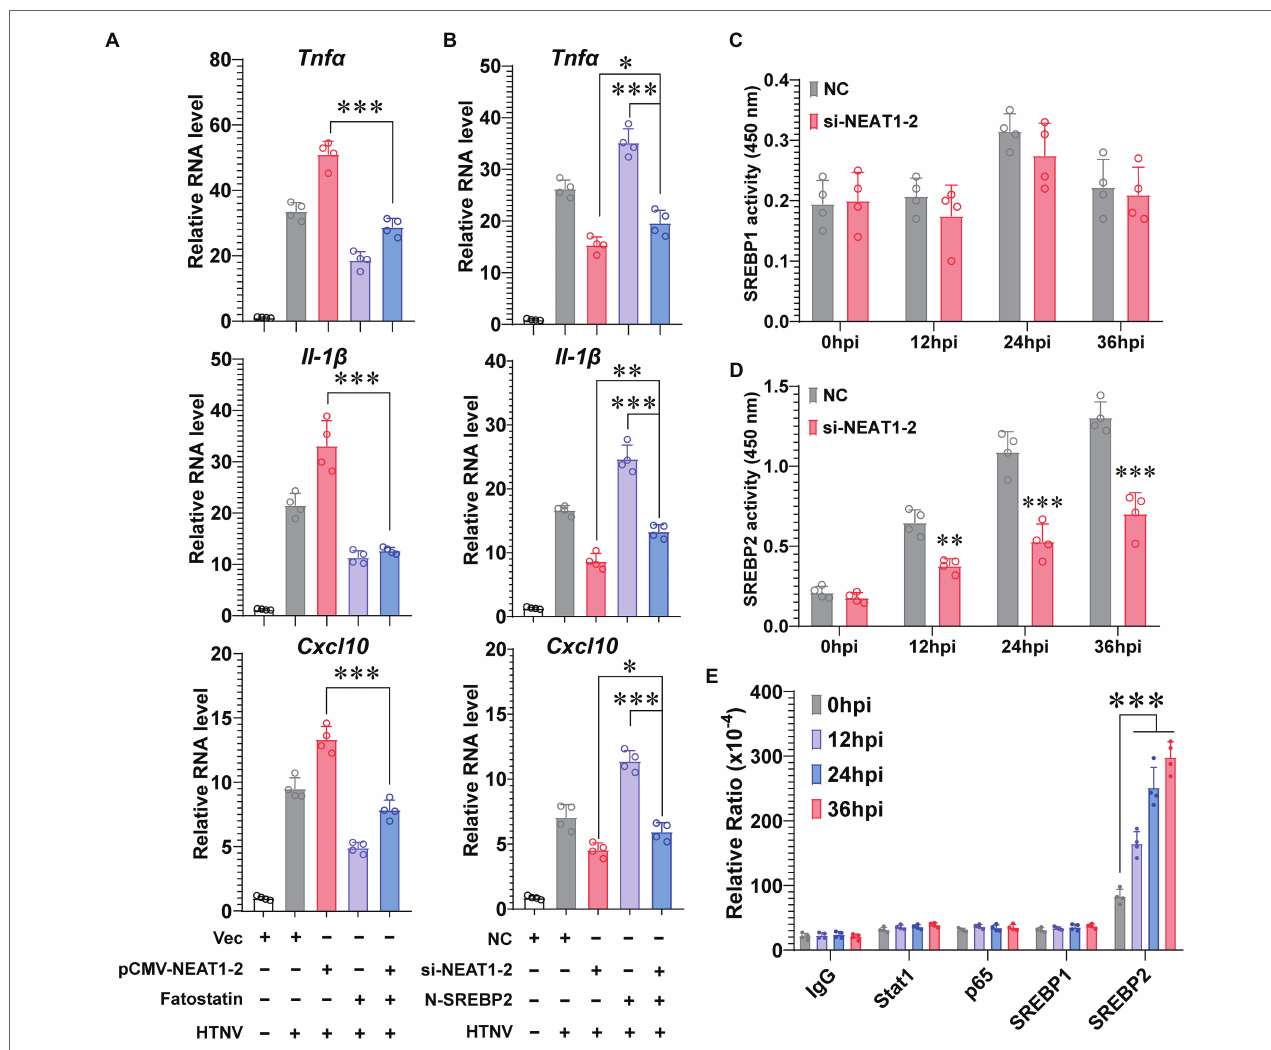
FIGURE 5 | NEAT1-2 Promotes SREBP-2-Dependent Inflammation in HTNV-infected Macrophages. (A) qRT-PCR analysis of proinflammatory genes in hMDMs with the indicated treatments. The hMDMs were electrotransfected with pCMV-NEAT1-2 or vectors for 24 h and then infected with HTNV at an MOI of 5 with or without fatostatin (20 μ M) treatment. Cells were collected for qRT-PCR at 36 hpi. (B) qRT-PCR analysis of proinflammatory genes in hMDMs with the indicated treatments. The hMDMs were electrotransfected with si-NEAT1-2 and/or plasmids coding N-SREBP2 and then infected with HTNV at an MOI of 5. Cells were collected for qRT-PCR at 36 hpi. (C) Detection of the transcriptional activity of SREBP1 in hMDMs from 0 to 36 hpi. (D) Detection of the transcriptional activity of SREBP2 in hMDMs from 0 to 36 hpi. (E) RIP assays to measure the enrichment of NEAT1-2 by different transcription factors. HEK 293T cells were transfected with plasmids expressing Stat1, p65, SREBP1 or SREBP2 and then infected with HTNV at an MOI of 5. Cells at various time points after HTNV infection were collected for RIP analysis. Data are shown as the mean ± SEM and are representative of three independent experiments. Each point represents a single sample ( n = 4 in each group. Analysis was performed using the unpaired Student’s t -test (A–D) or one-way ANOVA (E) . * p < 0.05, ** p < 0.01, and *** p <